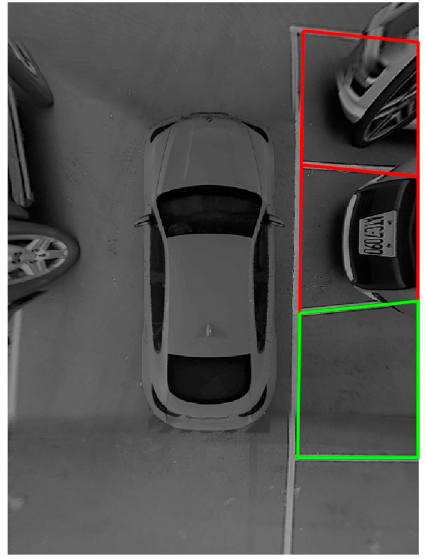
Figure 19. Space occupancy classification results.